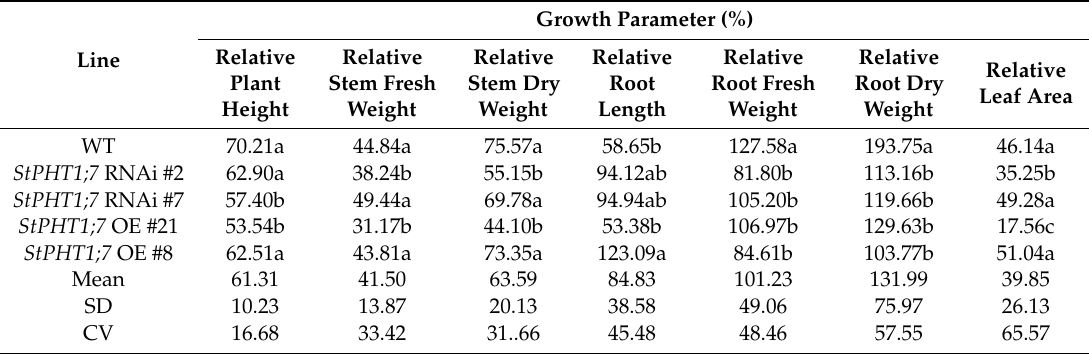
Table 1. Multiple comparisons of the relative growth indices under 15% PEG6000-induced drought stress of the in vitro potato plantlets of five